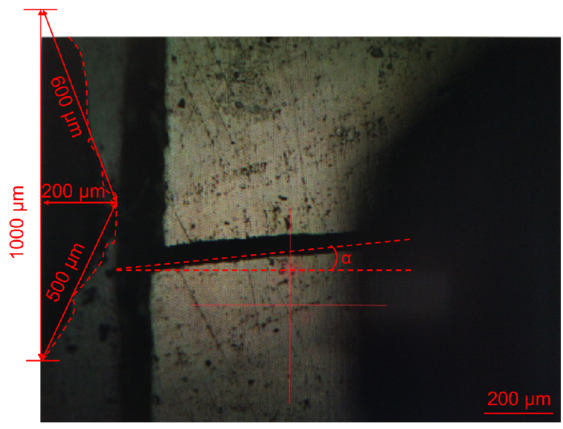
Figure 4. Dimensions of the